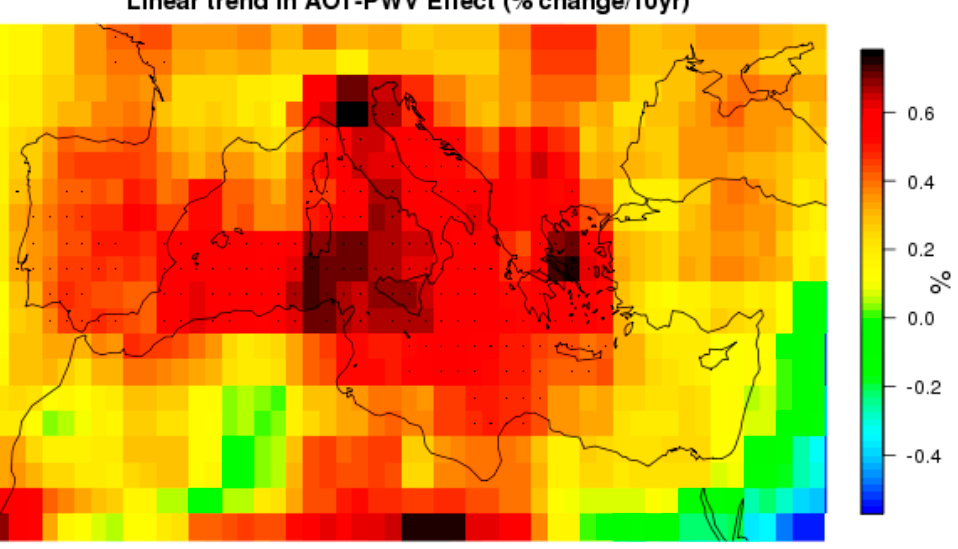
Figure 10. Spatial distribution of linear trend in AOT-PWV effect for 2000–2018 per decade. Pixels with levels of significance p <0.05 are marked with a black dot.